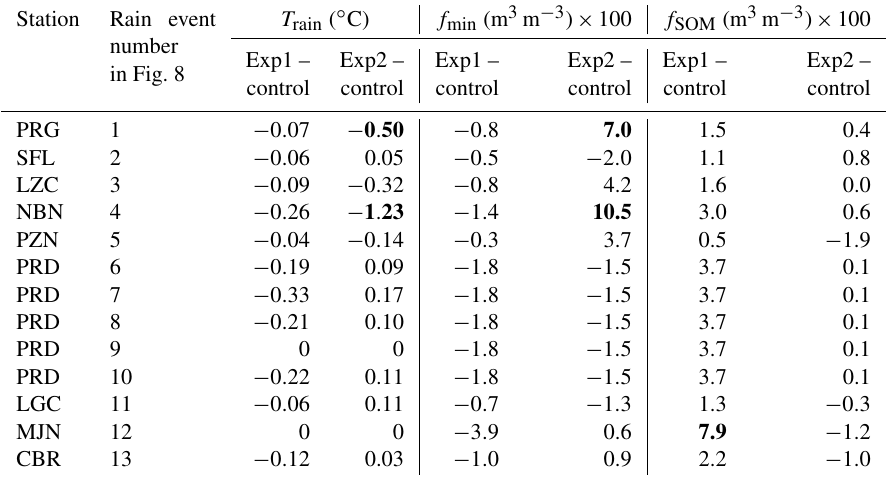
Table 6. The estimated T rain differences, f min differences, and f SOM differences between Exp1 and control and between Exp2 and control. Changes in values of T rain larger than ± 0 . 5 ◦ C are in bold. Changes in values of volumetric fractions larger than 0.05m 3 m − 3 are in